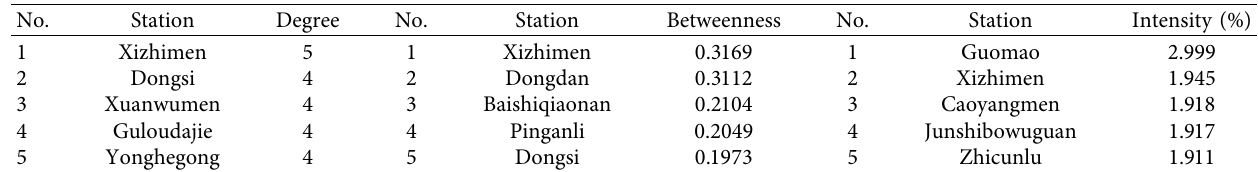
Figure 7: Topology and initial passengers of Beijing subway network (a–c). Table 1: Results of top 5 importance nodes.